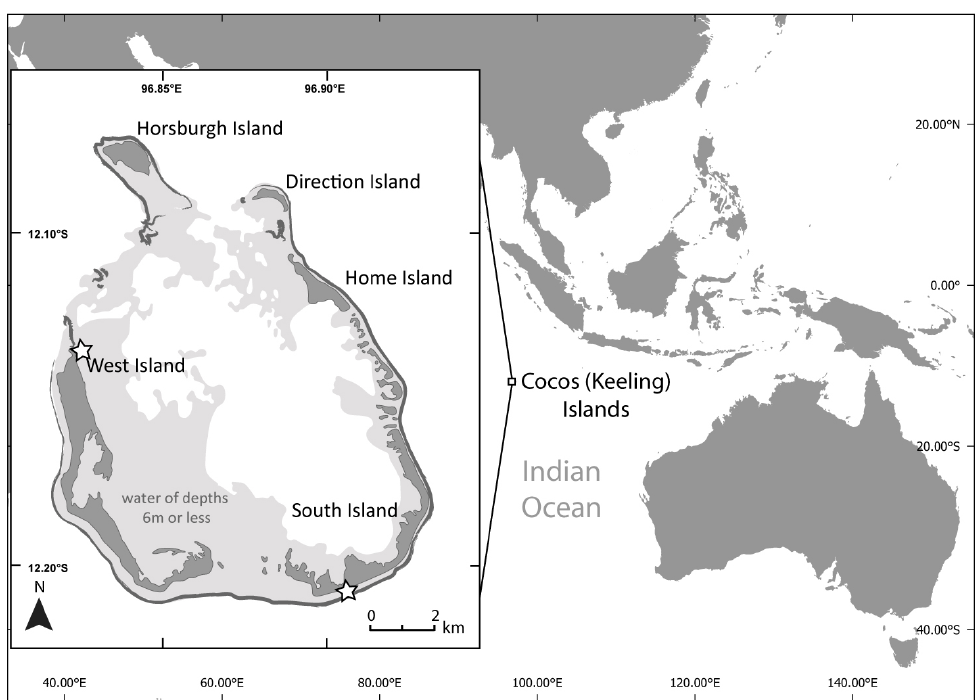
Figure 1. The Cocos (Keeling) Islands (North Keeling atoll not shown). West and Home Islands have permanent settlements, while Direction Island is a popular tourist location. South Island is more remote and is visited infrequently. Location of field sites indicated with stars, the barrier reefs are shown in dark grey and areas of shallow water in light